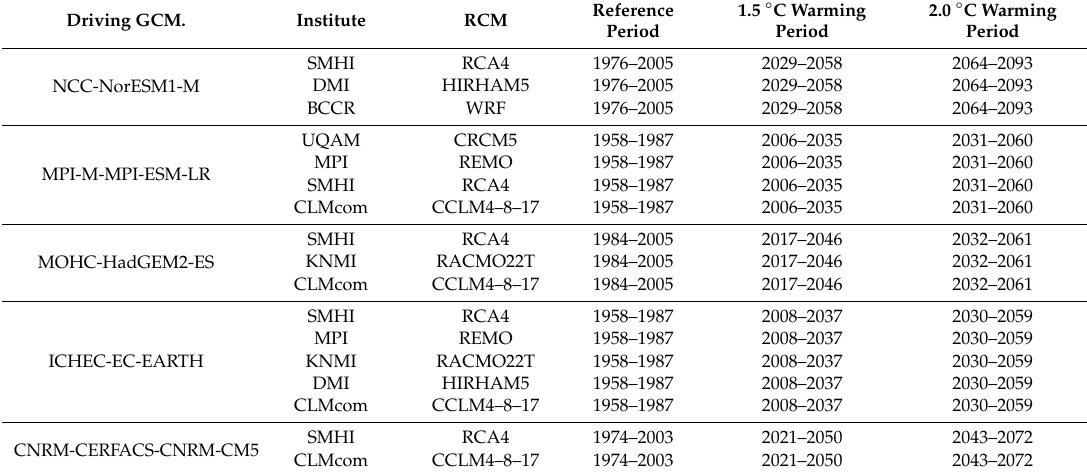
Table 1. Climate model data with the name of the driving global climate model (GCM), institute, regional climate model (RCM), and the different periods of simulations. The reference period is the historical period obtained with 0.5 °C warming, with respect to the preindustrial in the same way as both targets (1.5 °C and 2 °C) in the future.